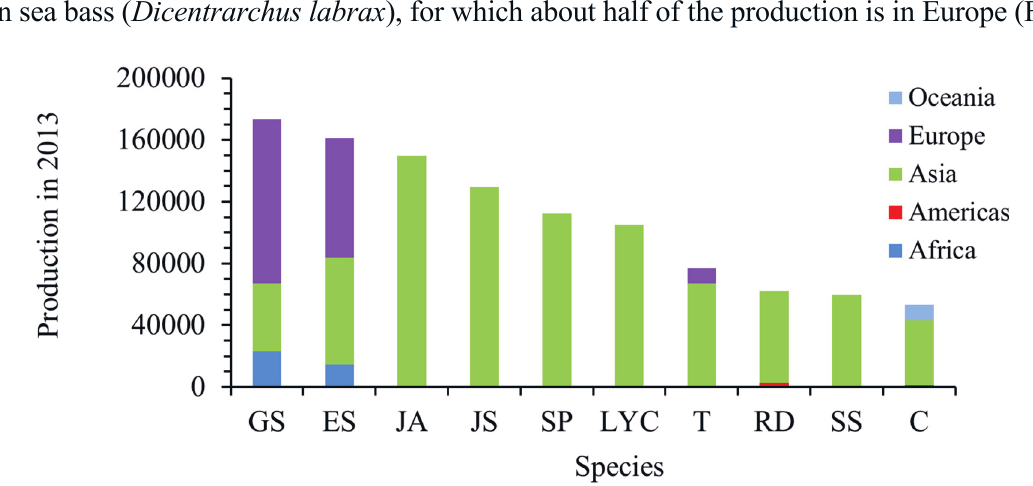
Figure 6. Aquaculture production of the top ten farmed marine species. Gilthead seabream (GS); European seabass (ES); Japanese amberjack (JA); Japanese seabass (JS), subnose pompano (SP); large yellow croaker (LYC); turbot (T); red drum (RD); silver seabream (SS) and cobia (C) (see Appendix for scientific